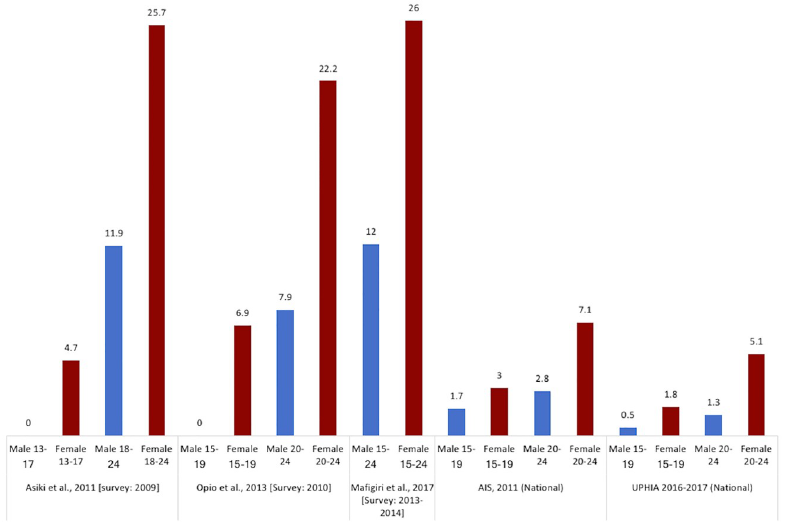
Fig 5. Prevalence of HIV among young people in fishing communities. AIS: AIDS Indicator Survey (national data from the general population); UPHIA: Ugandan Population-based HIV Impact Assessment 2016–2017. The numbers represent the prevalence reported as percentage